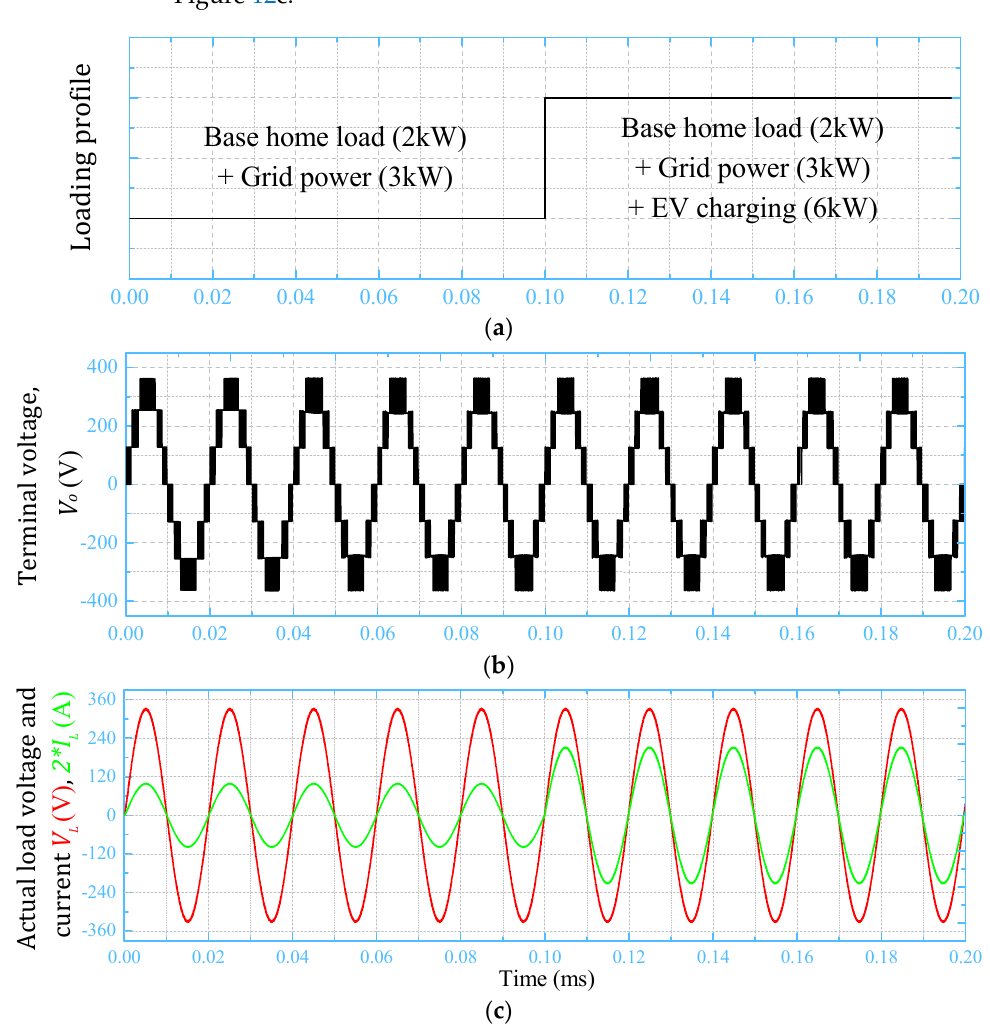
Figure 12. Simulation results of the proposed 7-level inverter as level-2 EV charger (240 V, 3:6 kW); ( a ) loading profile, ( b ) multilevel output voltage, and ( c ) inverter voltage/pulsating current.